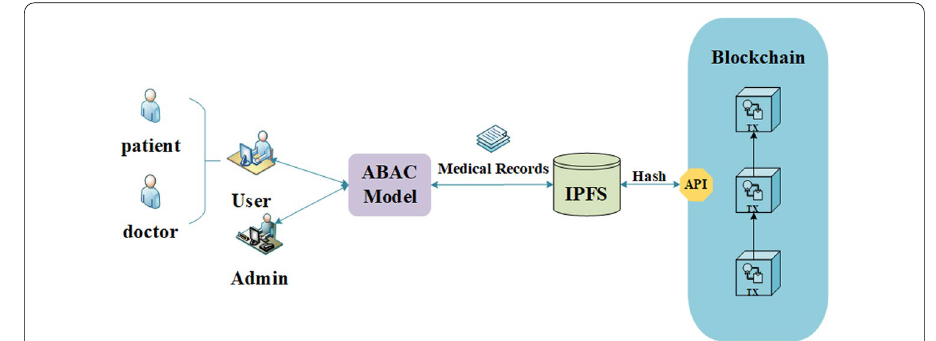
Fig. 5 The proposed scheme